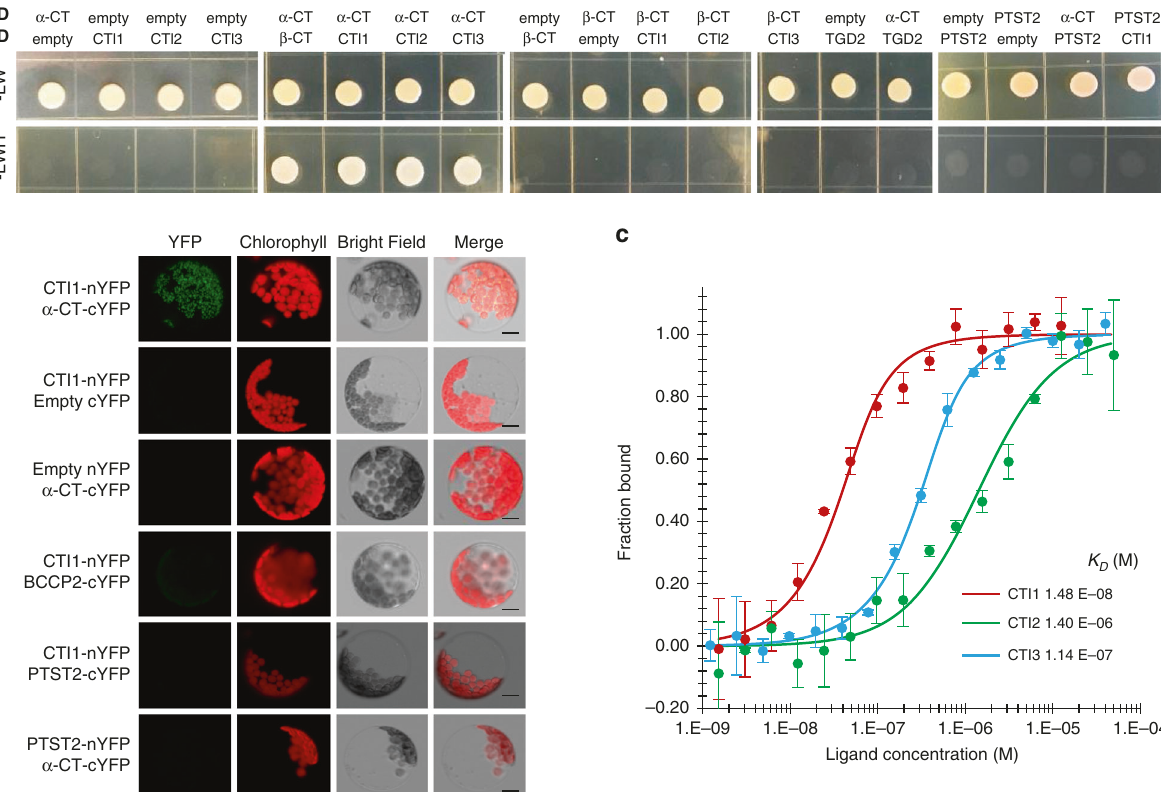
Fig. 1 CTIs physically interact with α -CT in vitro and in vivo. a Yeast two-hybrid assay testing interactions between pairs of proteins. Each protein tested was fused to a GAL4 DNA-binding domain (BD) or to a GAL4 activation domain (AD). Representative cells grown on synthetic dropout (SD)-LW or SD- LWH medium with 1 mM 3-amino-1,2,4-triazole are presented. The experiment was repeated three times with similar results. b BiFC assays. Experiments were repeated three times with similar results. For each of the three independent protoplast transformations, at least three different protoplasts were observed. Bars = 10 μ m. c Microscale thermophoresis (MST). Data points indicate the fraction of labeled α -CT coiled-coil domain bound to CTIs. Dissociation constants ( K D ), expressed in M, are presented. Data points are means± SD, n = 3 individual biological